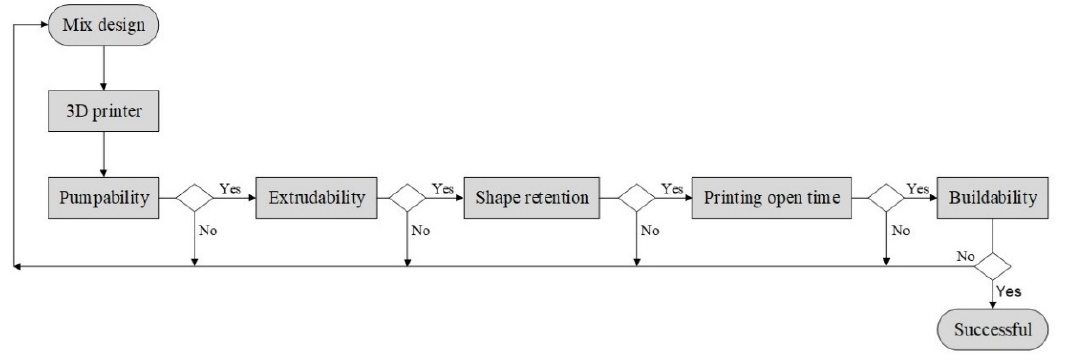
Figure 5. Iterative process of preparing a printable concrete mix. Table 3. Representative mix designs for 3D concrete printing.